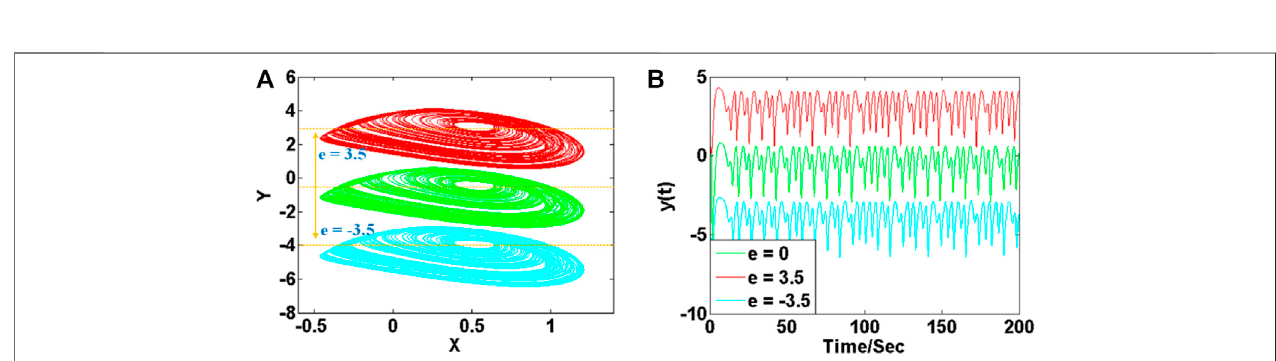
FIGURE 15 | Offset boosted attractors of system (11) with a (cid:1) 2.8, b (cid:1) 5.5, c (cid:1) 1.7, d (cid:1) 2.5: (A) attractors on plane of x-y , (B) signal y (t).